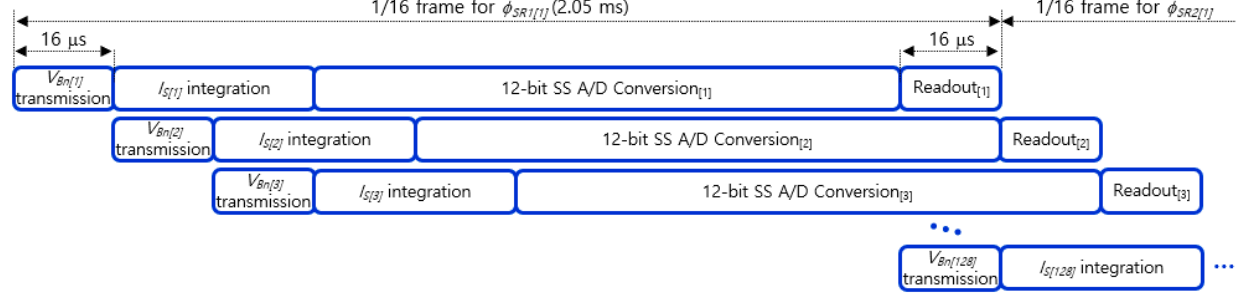
Figure 6. Timing diagram of the operation mode.